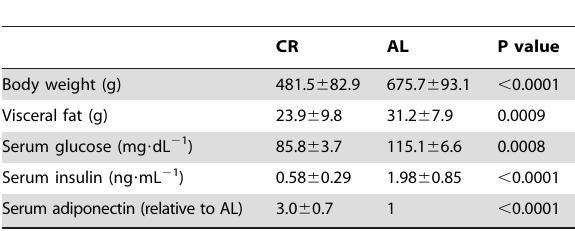
Table 1. Effects of CR and AL diets.